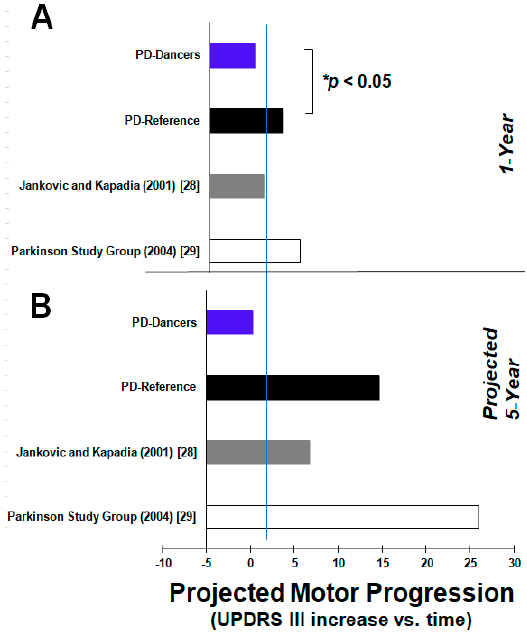
Figure 3. Total annual rate of motor score (UPDRS III) progression across all groups and studies discussed in the text. Based on reported values with Jankovic and Kapadia (2001) [28] the annual rate of progression during the ON ‐ state is quoted. Motor scores after ( A ) 1 year are plotted based on available data and ( B ) 5 years are projected for each group based on current slope measure ‐ ments.